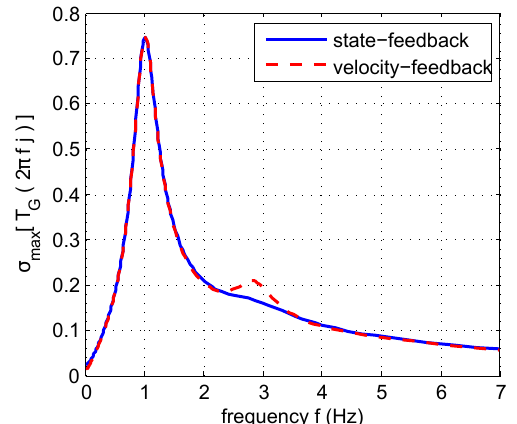
Figure 9: Centralized velocity-feedback controller with L = 0. Maximum singular values of the closed-loop pulse transfer functions corre- sponding to the centralized velocity-feedback controller u ( t ) = (cid:98) K y ( t ) (red dashed line) and the optimal state-feedback controller u ( t ) = (cid:101) G s x ( t ) (blue solid line)